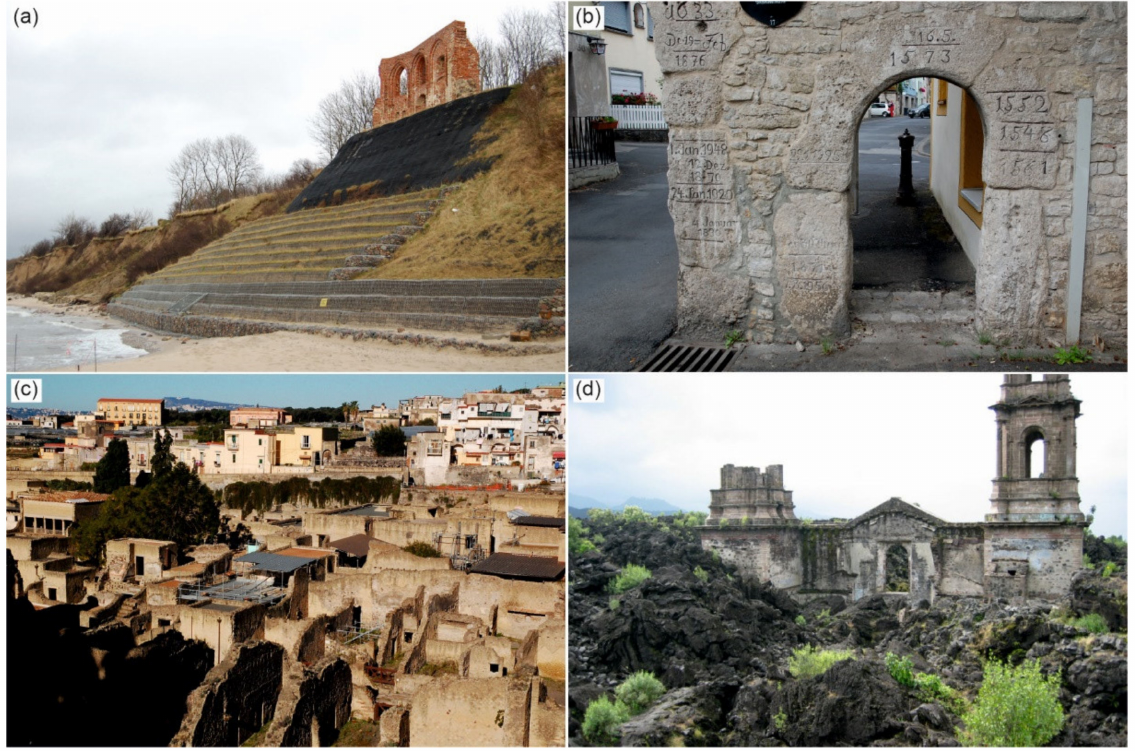
Figure 5. Natural hazards and disasters in the cultural heritage context. ( a ) remnants of a medieval church in Trz˛esacz, northern Poland, destroyed due to sea cliff retreat, ( b ) flood marks in the town of Eibelstadt on the River Main, Germany, ( c ) ruins of Herculaneum, Italy, excavated from beneath lahar and pyroclastic surge deposits from the AD79 eruption of Mt. Vesuvius, ( d ) ruins of a church in San Juan Parangaricutiro, Mexico, destroyed by a lava flow from the Par í cutin volcano in 1944 (all photographs by the